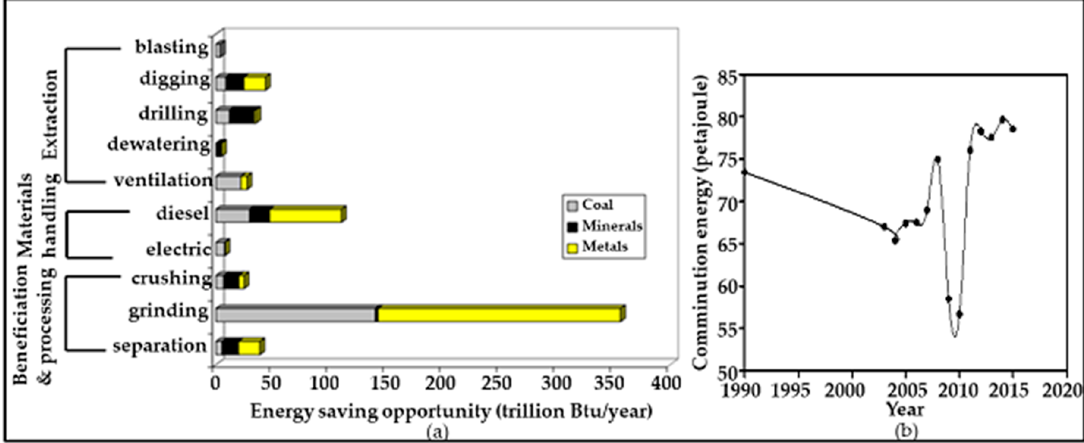
Figure 2. ( a ) Energy-saving opportunity for energy intensive process in mining [13]. ( b ) Comminution energy trend (Canada) between 1990 and 2015 (calculated based on 50% of total mining energy) (data source: [17]).